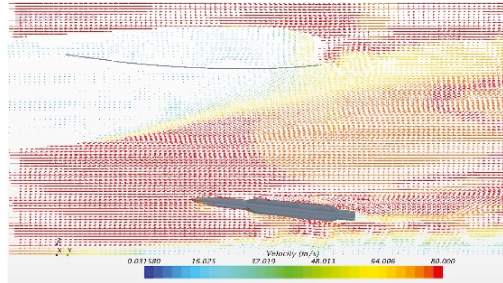
Figure 11: Flow fi eld velocity contour at 0.4s.